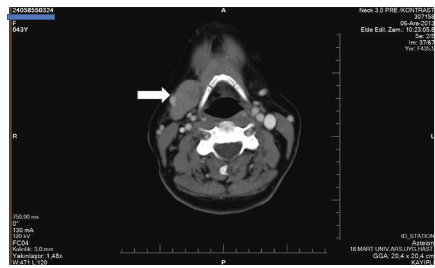
Figure 3: Noncontrast computed tomography axial sections demonstrate absence of left submandibular gland in the second case. White arrow shows the right submandibular gland.